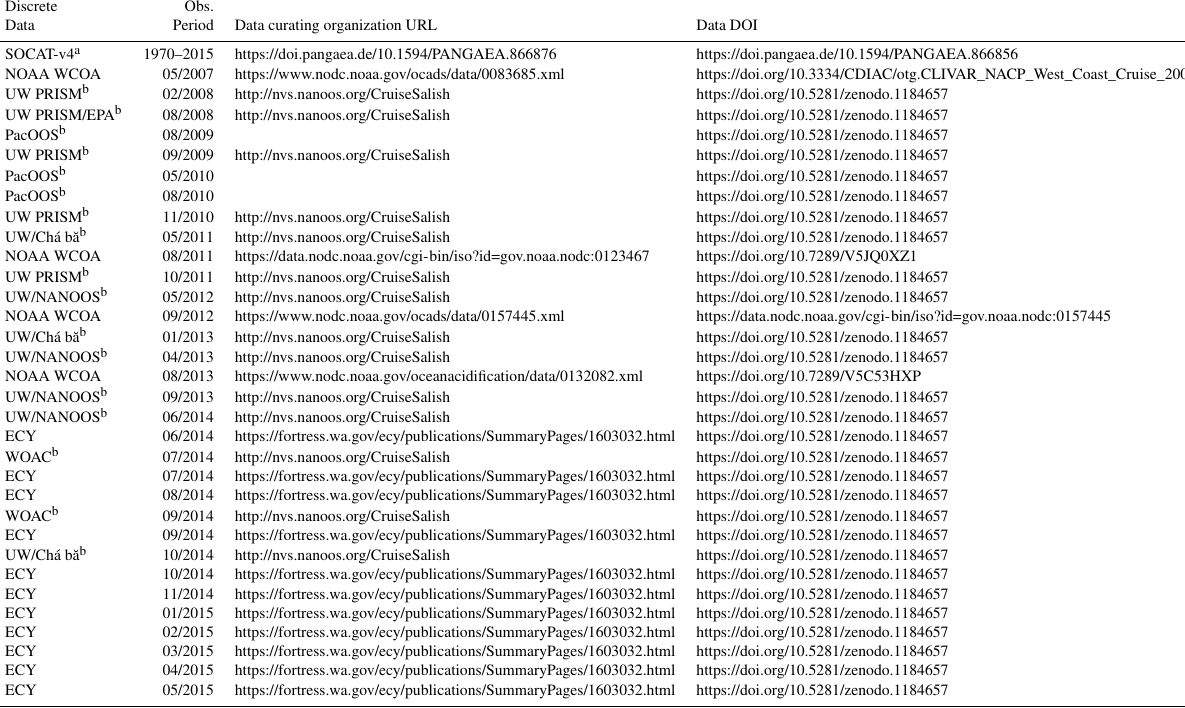
Table 1. Data attribution table listing the SOCAT and discrete datasets (with observing periods) incorporated into the analysis. Data curating organization URLs and data DOIs are